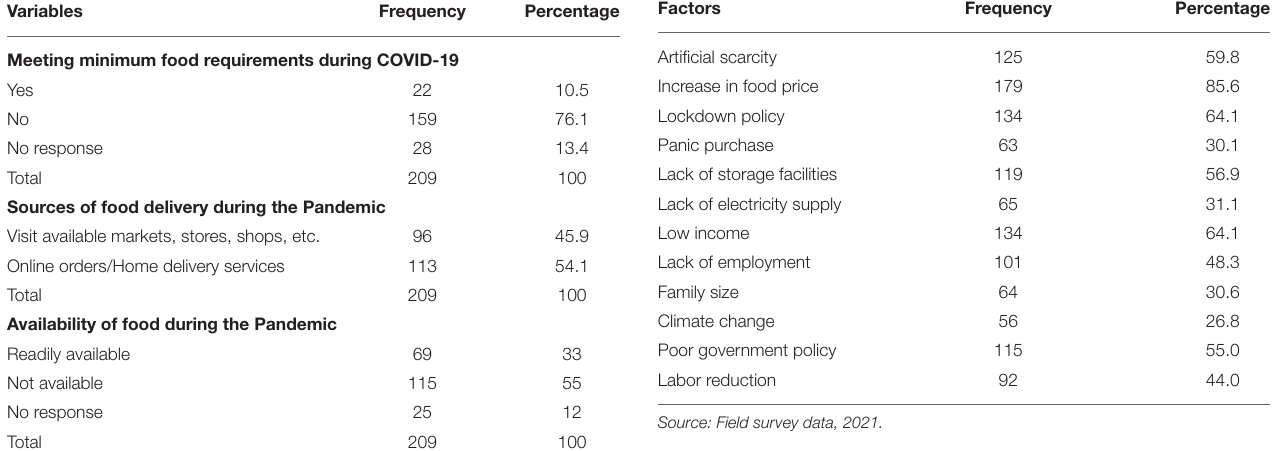
TABLE 5 | Minimum food requirements, source of food delivery, and availability of food during COVID-19 Pandemic. Variables